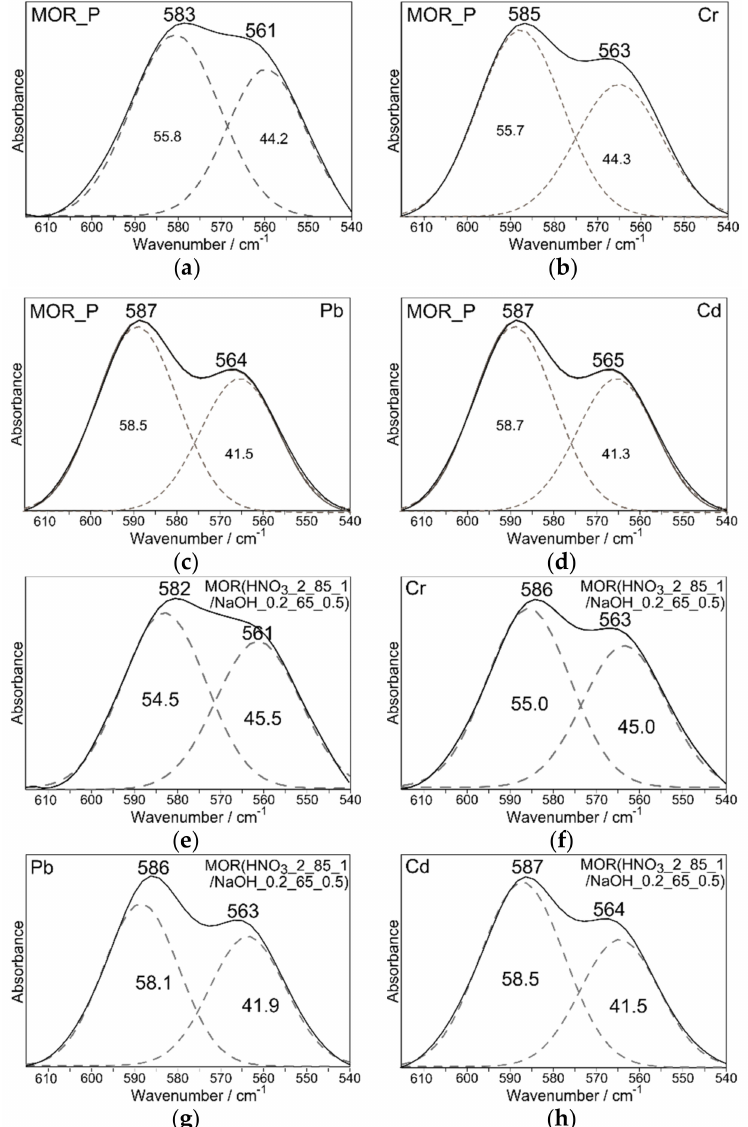
Figure 9. Decomposition of MIR spectra of MOR_P and MOR(HNO 3 _2_85_1 / NaOH_0.2_65_0.5) before ( a , e ) and after sorption of Pb 2 + ( c , g ), Cd 2 + ( d , h ) and Cr 3 + ( b , f ) ions from an aqueous solution (C 0 = 20 mmol / dm 3